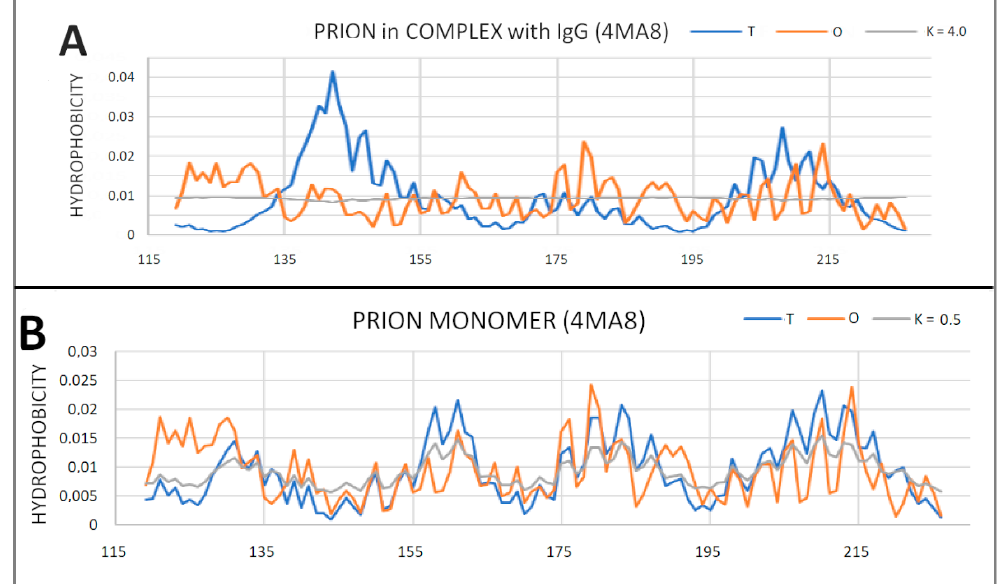
Figure 14. T, O and M profiles for the prion–protein complex with the Fab fragment of IgG. ( A ) Prion protein as part of the complex—3D Gaussian function generated for the complete complex; ( B ) prion protein treated as an individual structural unit (3D Gaussian function generated for prion protein individually).